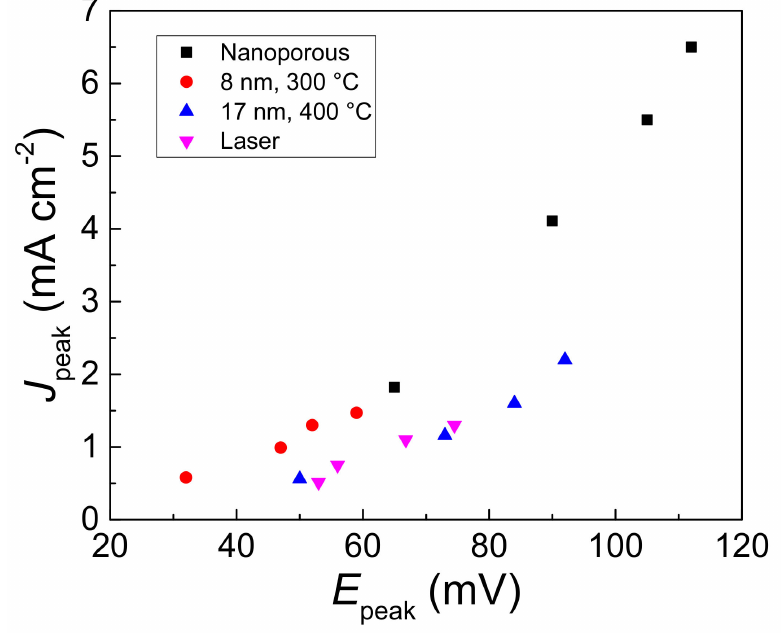
Figure 4. Current density as function of potential of the two electrons oxidation peak of the voltam- mograms of Figure 3a–d for 2.5; 5; 7.5; and 10 mM glucose in 0.1 M